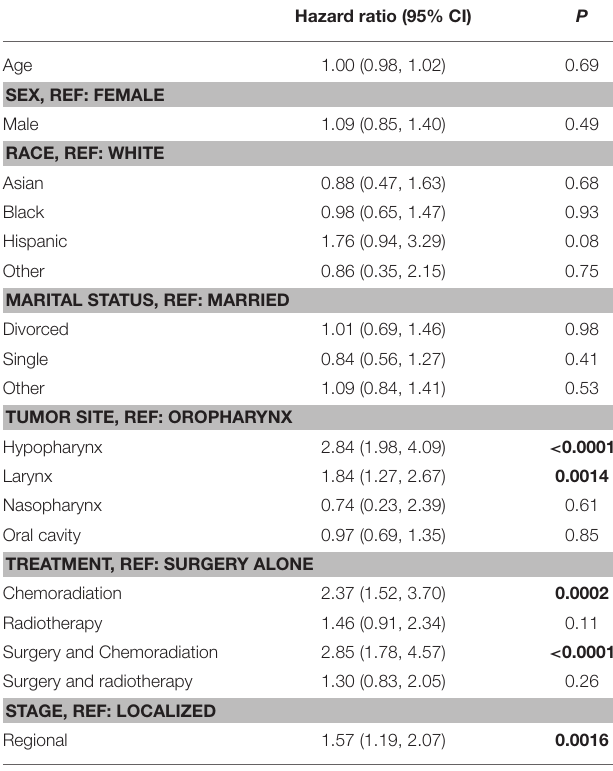
TABLE 2 | Multivariable analysis of risk factors for esophageal dilation